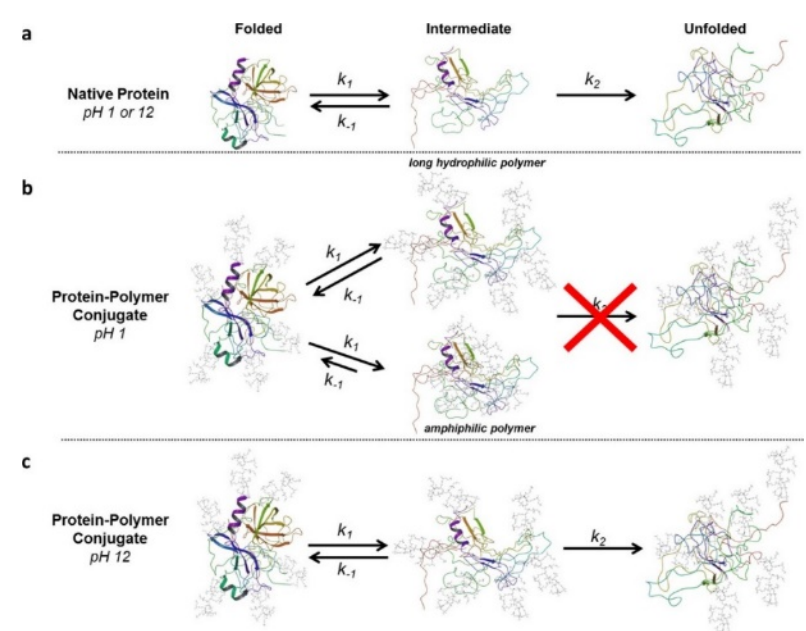
Figure 2. Unfolding pathways at different pH for ( a ) native chymotrypsin at pH 1 and 12, ( b ) PEGylated chymotrypsin at pH 1, and ( c ) PEGylated chymotrypsin at pH 12. PEG chains stabilize partially unfolded intermediate states and thus inhibit irreversible denaturation at pH 1 but not at pH 12 (reprinted with permission from [67] . Copyright (2018) American Chemical Society).